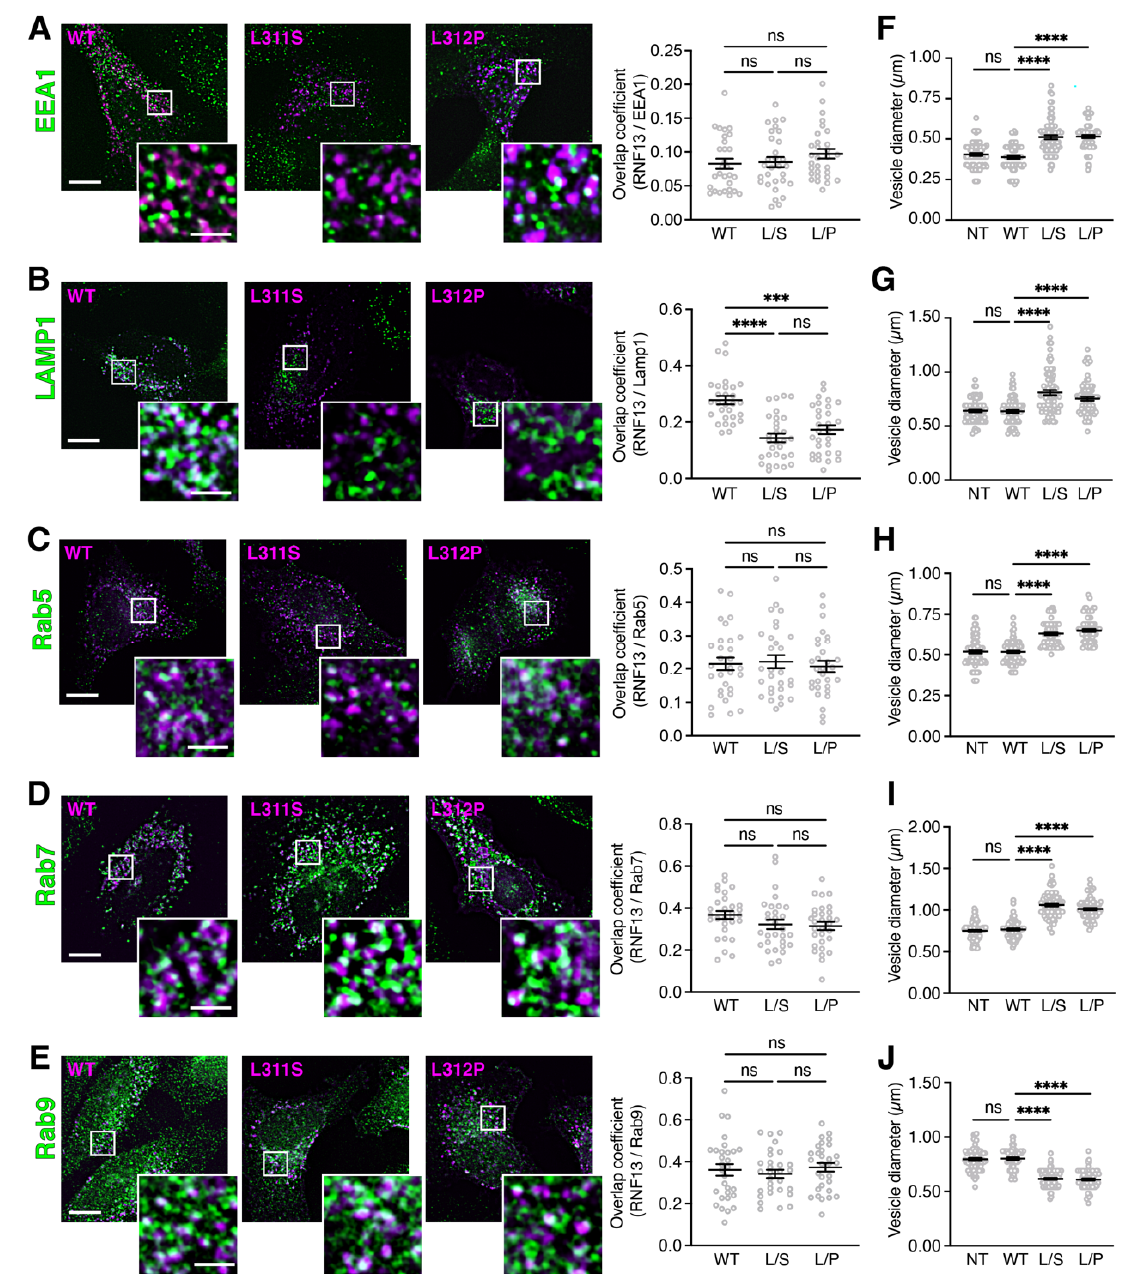
Figure 1. RNF13 L311S and L312P variants alter the size of endolysosomal vesicles. ( A – E ) Plasmid constructs encoding HA-tagged WT, L311S, or L312P RNF13 were transiently expressed in HeLa cells. Cells were fixed, permeabilized, and labeled with specific primary antibody against HA (RNF13) and against the endogenous subcellular markers. Representative images from three independent experiments (N = 3) show RNF13-HA (in purple) and ( A ) early endosome marker EEA1, ( B ) lysosome marker Lamp1, ( C ) early endosome marker Rab5, ( D ) late endosome marker Rab7, and ( E ) recycling endosome marker Rab9 (in green). Scale bars indicate 10 µm for whole cell image and 2 µm for the boxed area shown at higher magnification. The jittered individual value plots ( A – E ) represent Manders overlap coefficient of RNF13 over ( A ) EEA1, ( B ) Lamp1, ( C ) Rab5, ( D ) Rab7, or ( E ) Rab9. For each condition analyzed: N = 3, n = 30 cells. Values are expressed as mean ± SEM. Not significant (ns), *** p = 0.0004 or **** p < 0.0001 using one-way ANOVA with the Kruskal–Wallis test. The jitter strip plots (( F ), EEA1; ( G ), Lamp1; ( H ), Rab5; ( I ), Rab7; ( J ) , Rab9) represent the diameter of the five largest vesicles for each cell. For each condition analyzed: N = 3, n = 15 cells, 75 vesicles. Values are expressed as mean ± SEM. Not significant (ns) or **** p < 0.0001 using one-way ANOVA with the Kruskal–Wallis